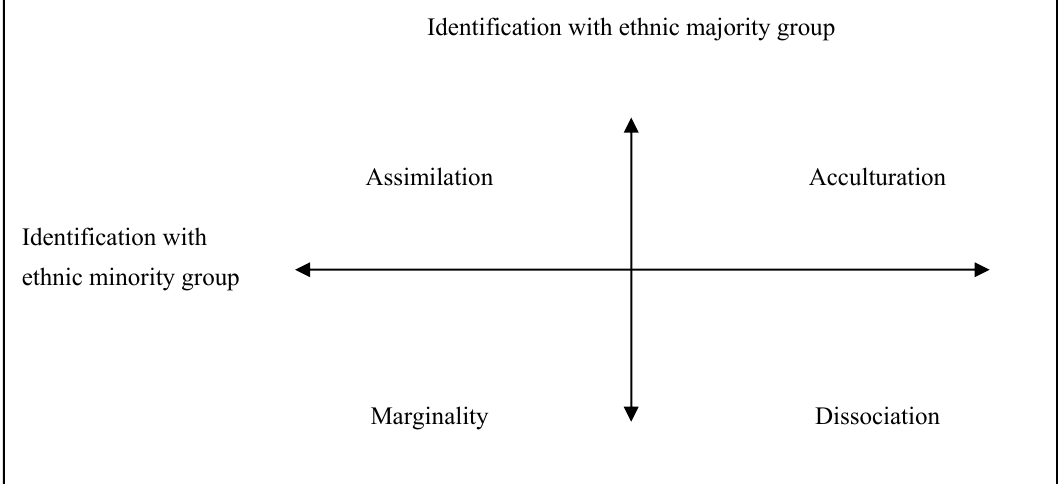
Figure 1. Model of identity of ethnic minority groups by N. Hutnik (1991) [8].